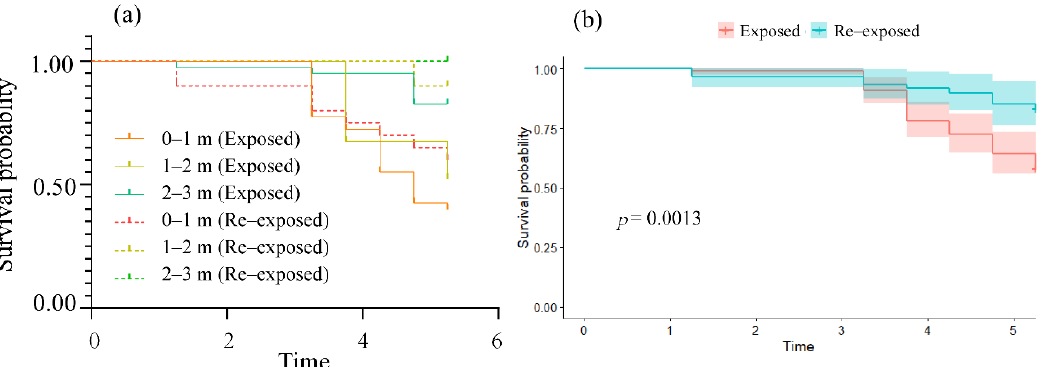
Figure 5. Survival characteristics of re-introduced and newly introduced adult S. prenanti in 0 – 1 m, 1 – 2 m, and 2 – 3 m depths: ( a ) survival curve for six scenarios; ( b ) survival probability with 95% confidence interval using the Cox proportional hazards model for the exposure group and the re- exposure group.